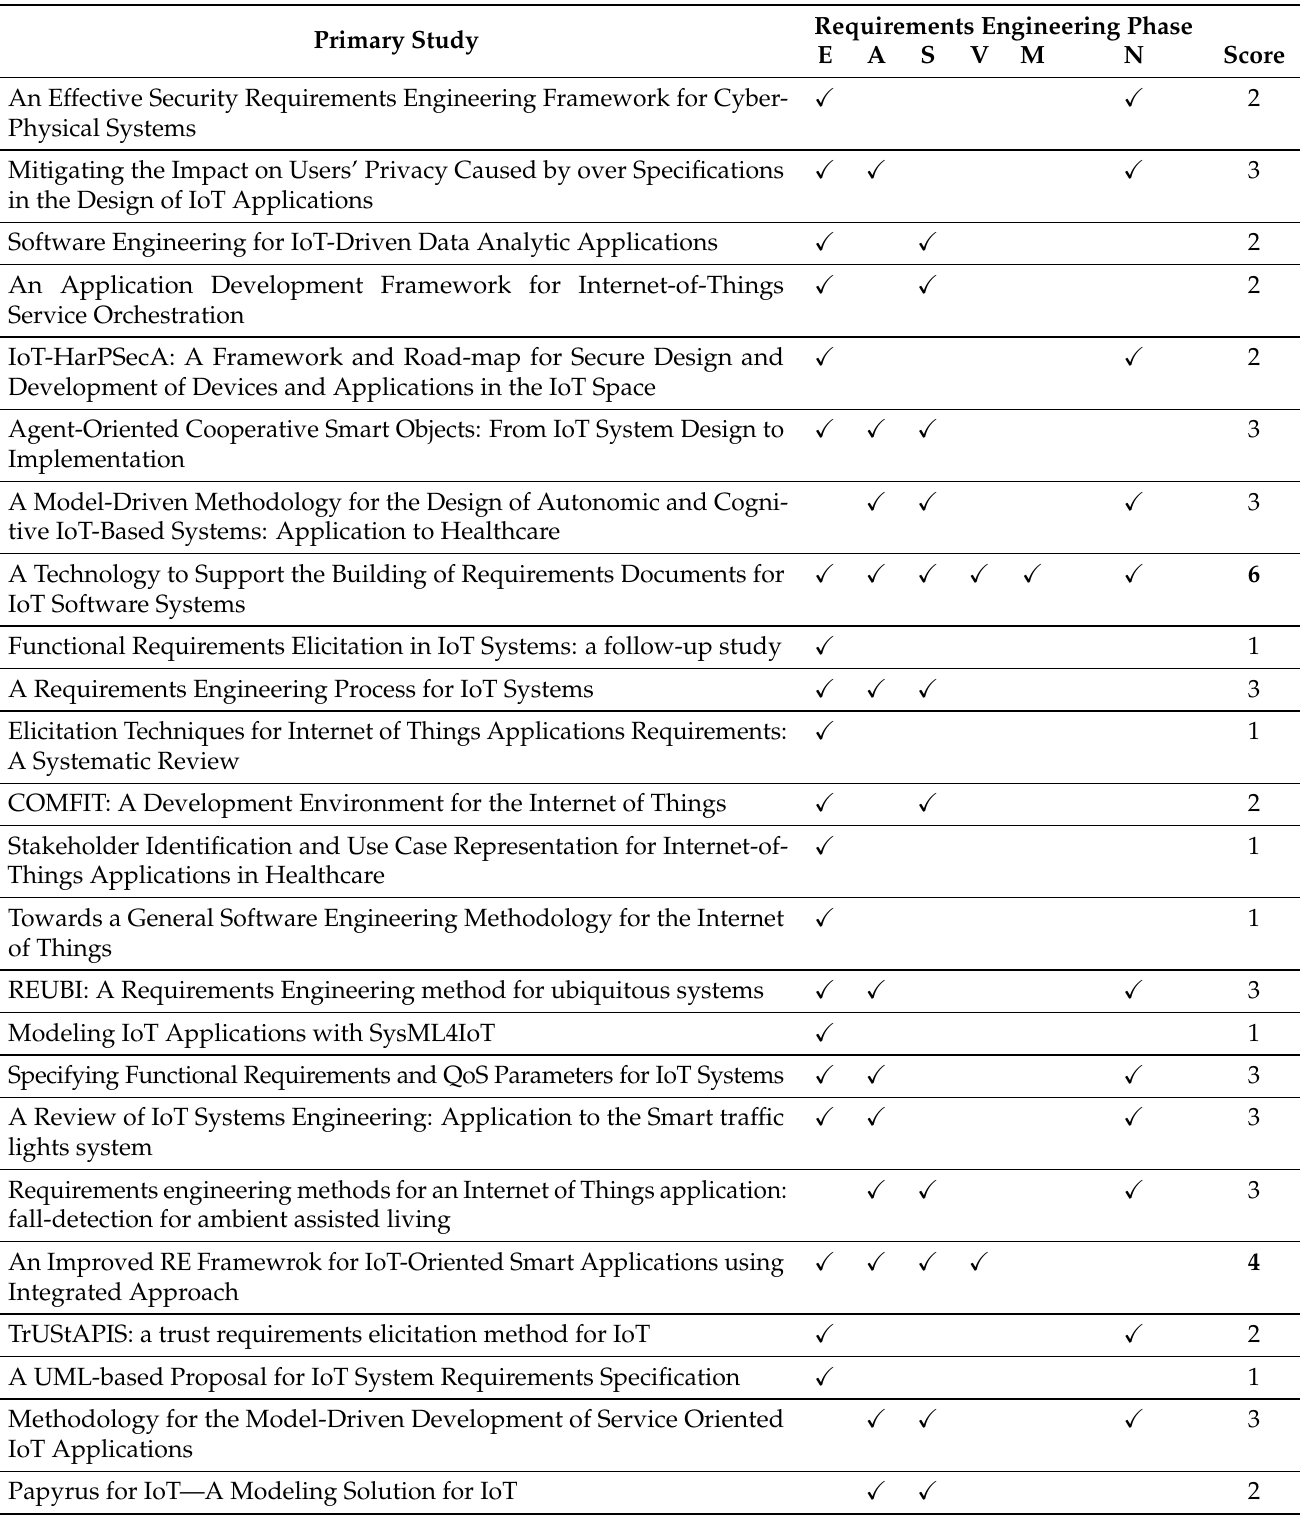
Table 4. Classification scheme per requirements engineering